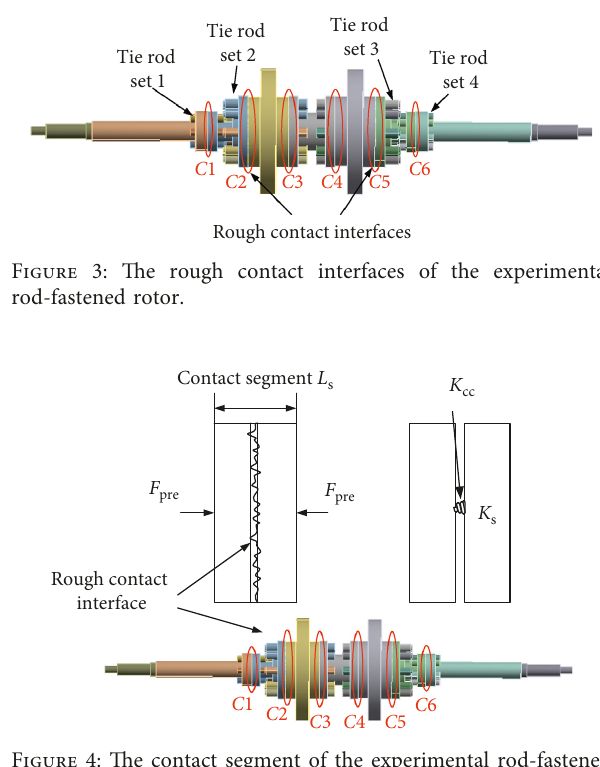
Figure 4: The contact segment of the experimental rod-fastened rotor.